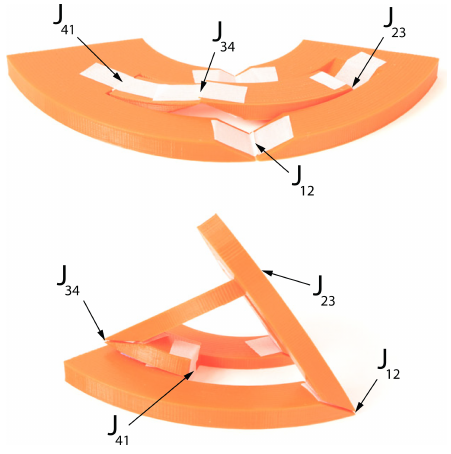
Figure 6. Example of a spherical deploying strut ThUDS. Shown in flat and deployed states. Joint names shown for